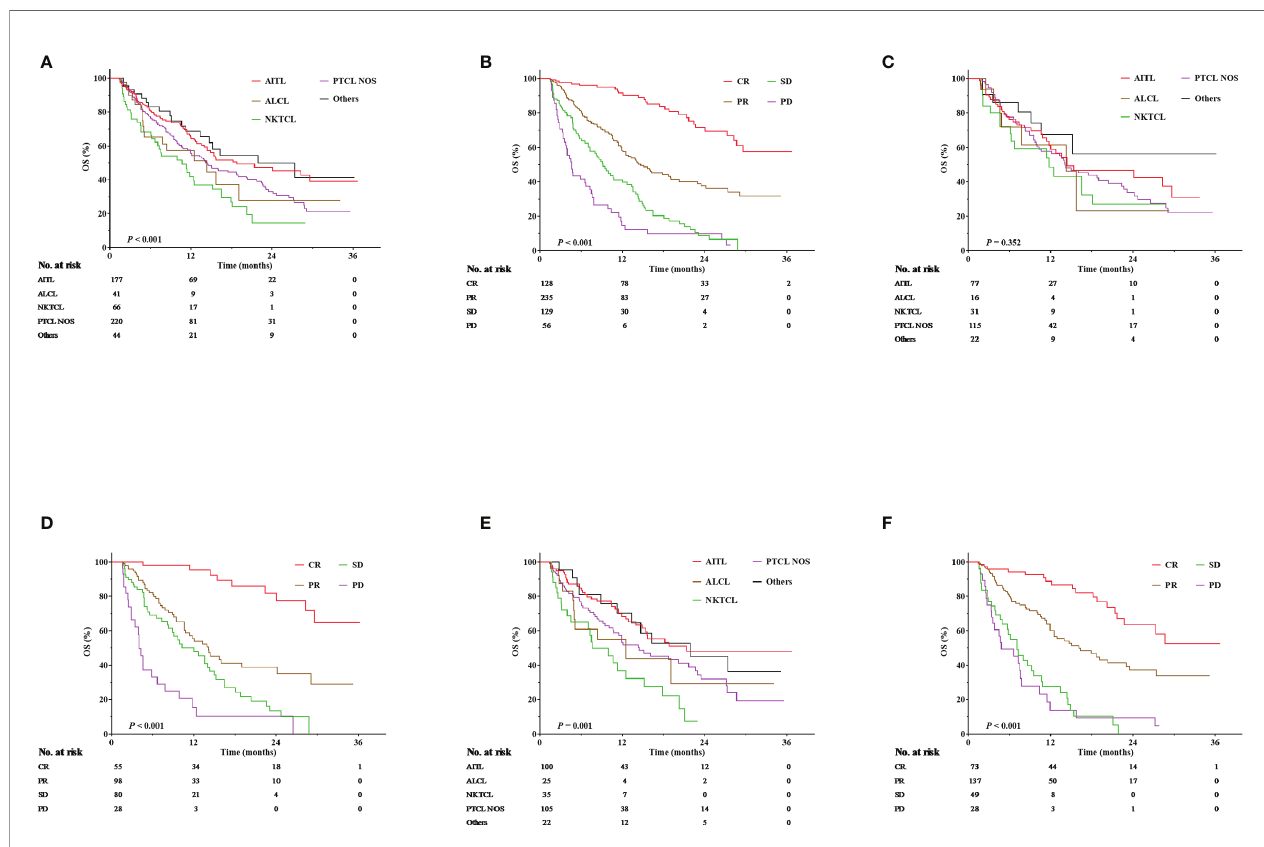
FIGURE 1 | Overall survival (OS) according to pathological subtypes and treatment responses. (A) OS according to pathological subtypes for the entire cohort. (B) OS according to treatment responses for the entire cohort. (C) OS according to pathological subtypes for those treated with chidamide monotherapy. (D) OS according to treatment responses for those treated with chidamide monotherapy. (E) OS according to pathological subtypes for those treated with chidamide- containing combined therapies. (F) OS according to treatment responses for those treated with chidamide-containing combined